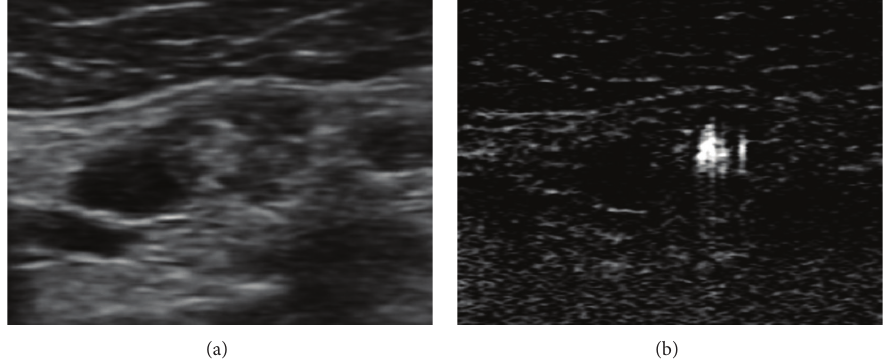
Figure 2: Metastatic lymph nodes at B-mode and BFI examination in patients with papillary thyroid cancer. The lymph node presents microcalcifications and multiple BFI-TS in the same place.